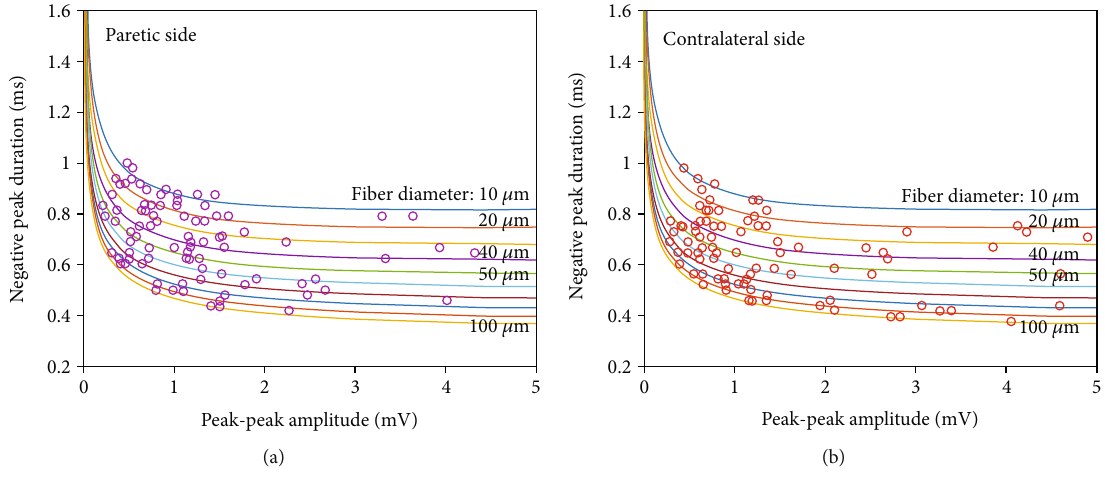
Figure 3: The estimated fi ber diameters from paretic and contralateral FDI muscles.